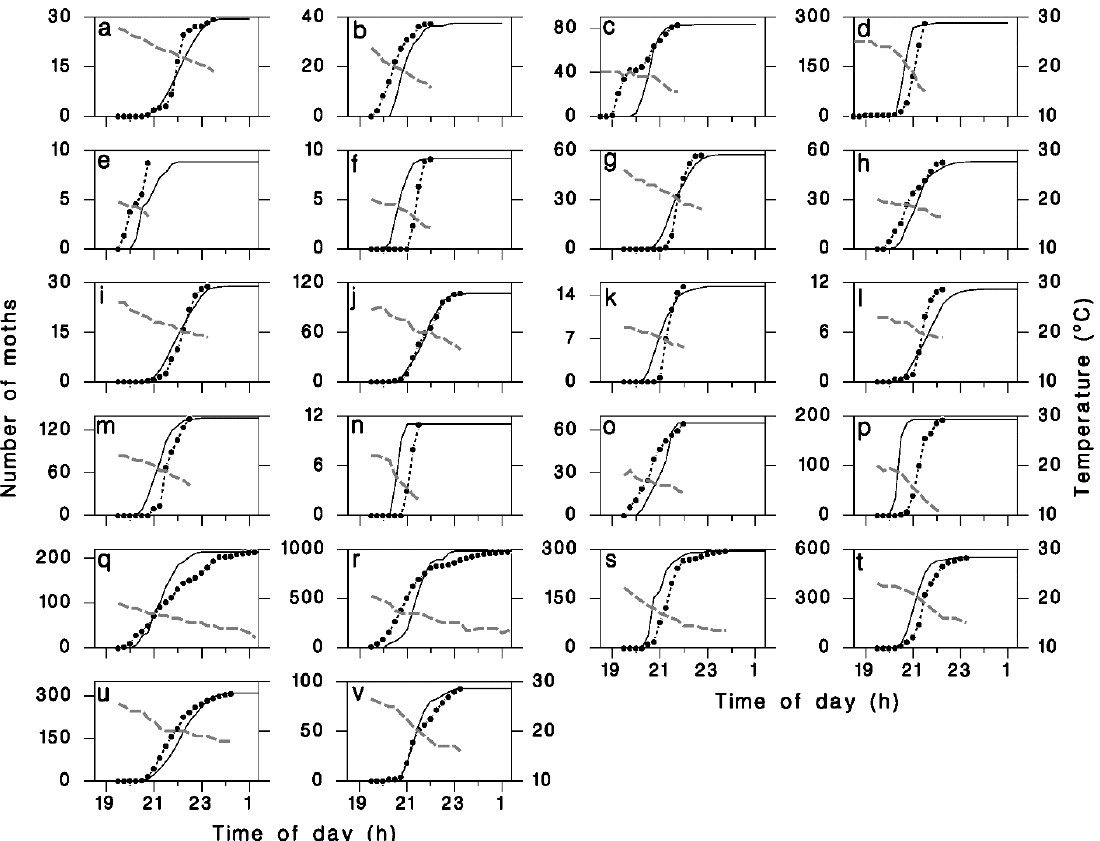
Figure 3. Observed (closed circles with dotted lines) and simulated (solid lines) cumulative moths